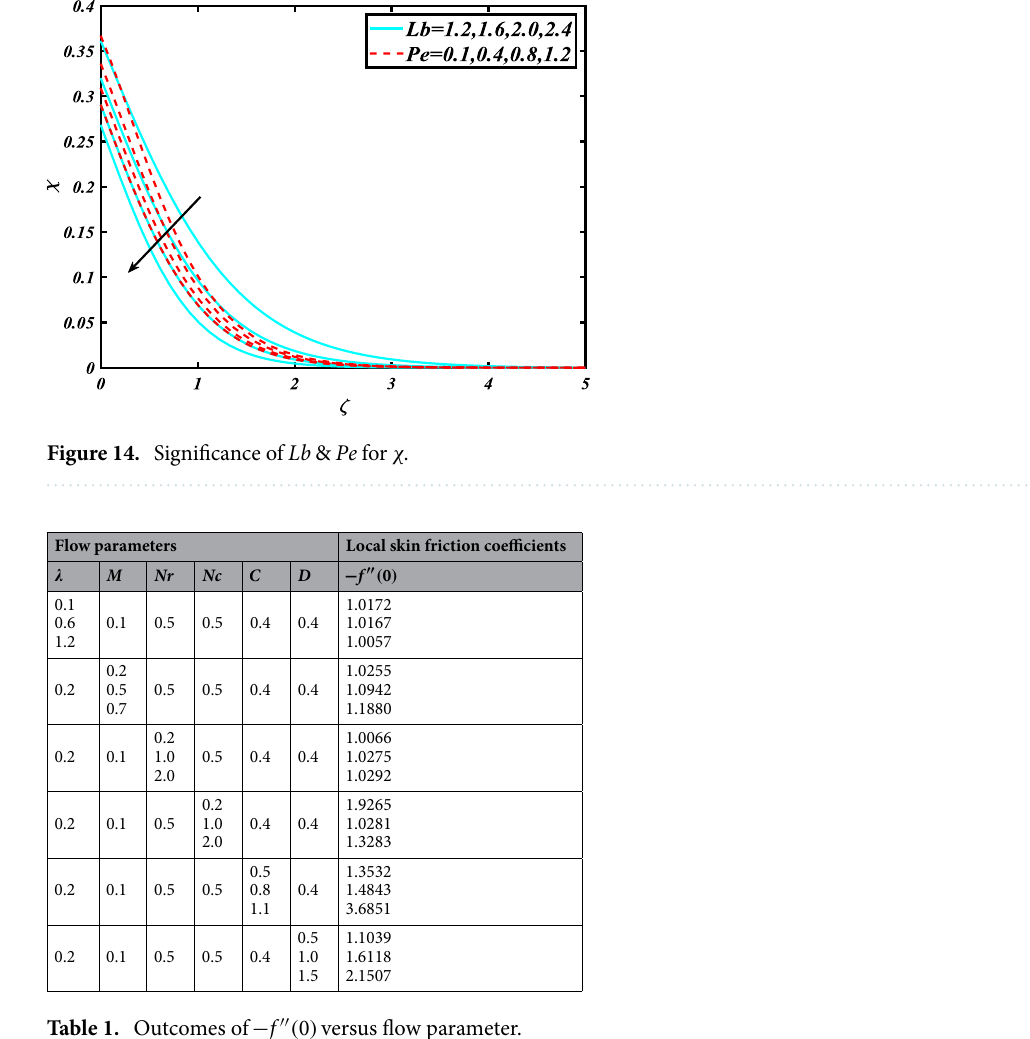
φ ′ ( 0 ) rises for Pr & S 2 . The numerical outcomes of local microorgan- table disclosed that local Sherwood number − χ ′ ( 0 ) via flow parameters are shown in Table 4. Now local density number of ism numbers − for higher variations C & Lb . Table 5 presents a comparative work of the current outcomes with refs. 8,43 . Here good agreement is observed with current results and published literature Ref. 8,43 .